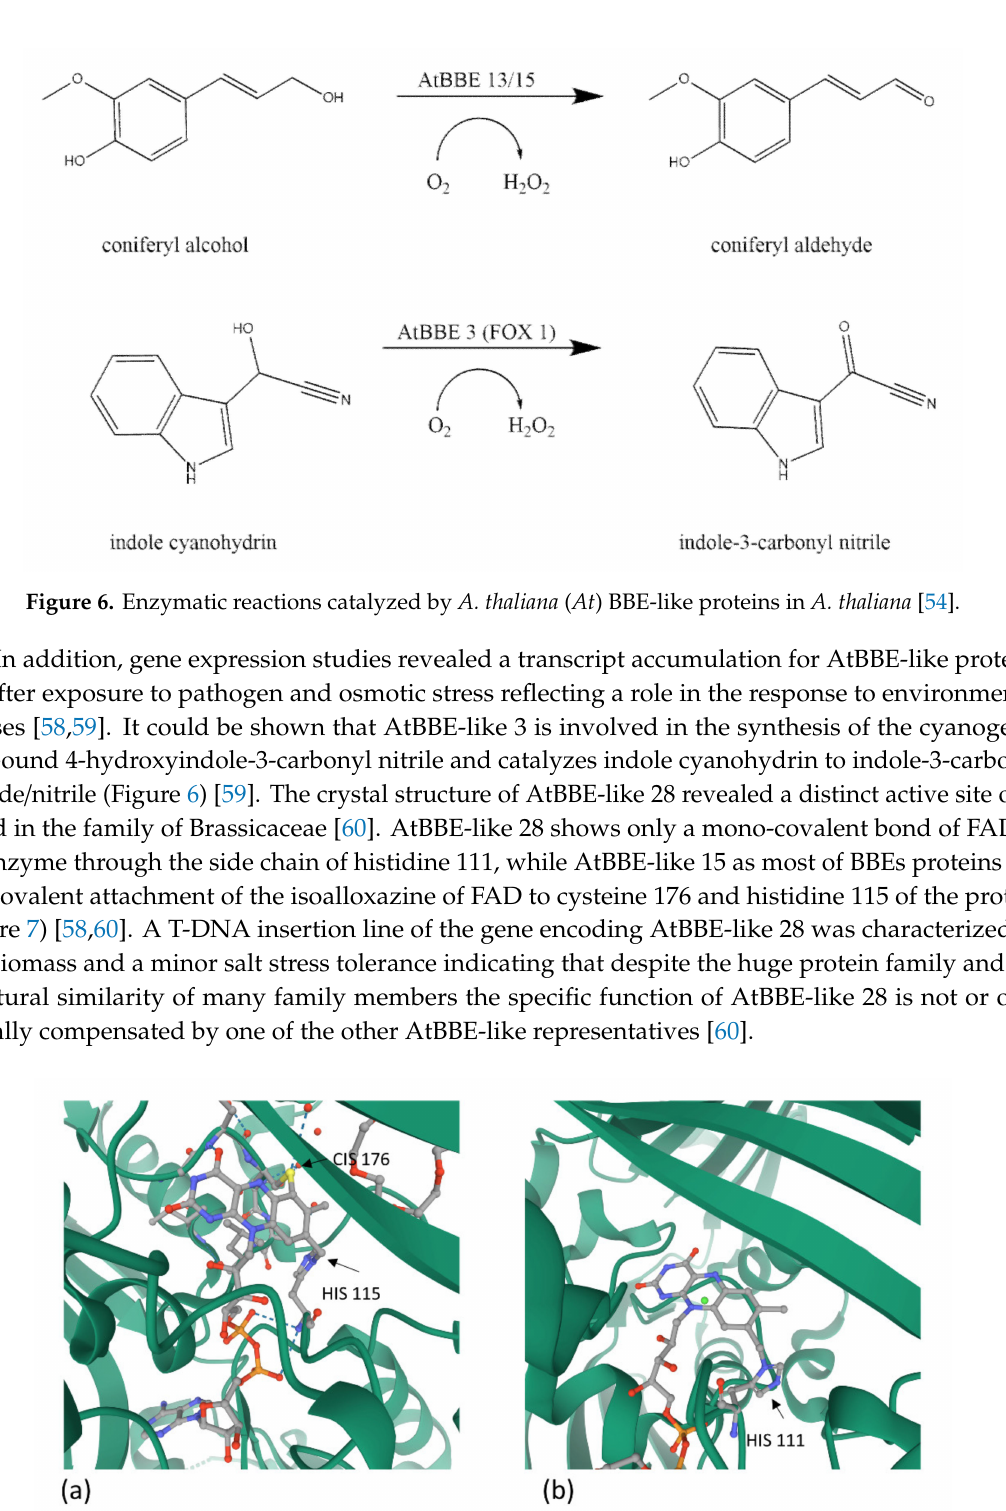
Figure 7. ( a ) Bi-covalent binding of FAD to At BBE15 (PDB ID: 4DU8) [58]. ( b ) Mono-covalent binding of FAD to At BBE-like 28 (PDB ID5D79) [61]. A part of the to protein structures is always presented in a green ribbon diagram which consists the FAD-binding sites with the contributing amino acid residues (with spheres in grey for C, in red for O, in orange for P, in blue for N and in yellow for S